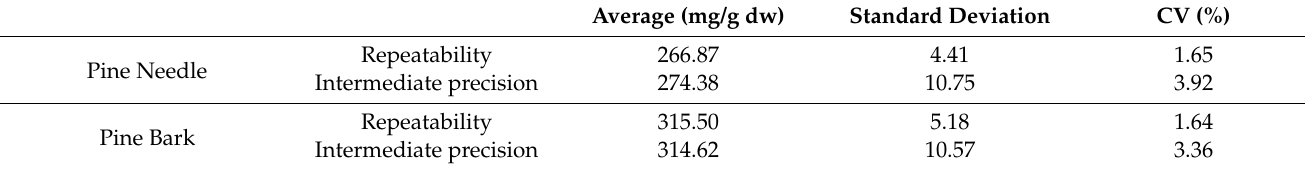
Table 4. Repeatability ( n = 6) and intermediate precision ( n = 18) tests for polyphenols recovery from pine needles and bark